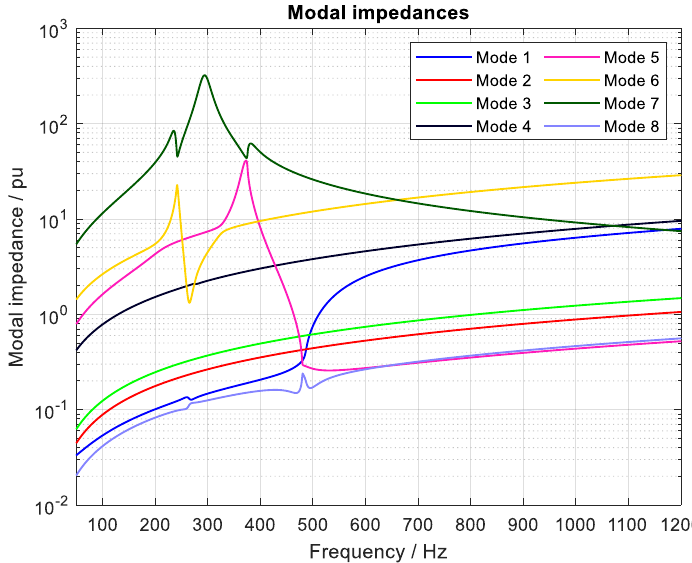
Figure 11. Modal impedances of the network with short-circuited bus 6.